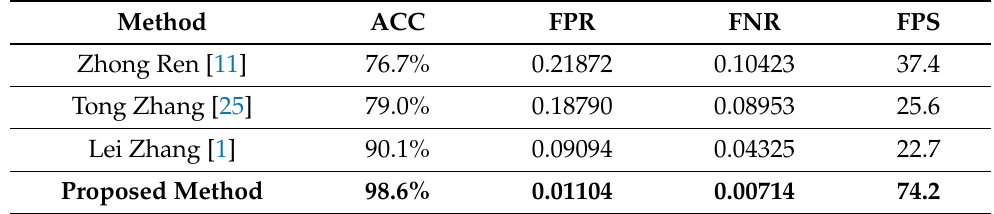
Figure 8. Test results of rail lines. The first column: the original images. The second column: the RailNet output. The third column: the final rail lines prediction. Table 3. Comparison of the results of the state-of-the-art rail lines detection algorithms.